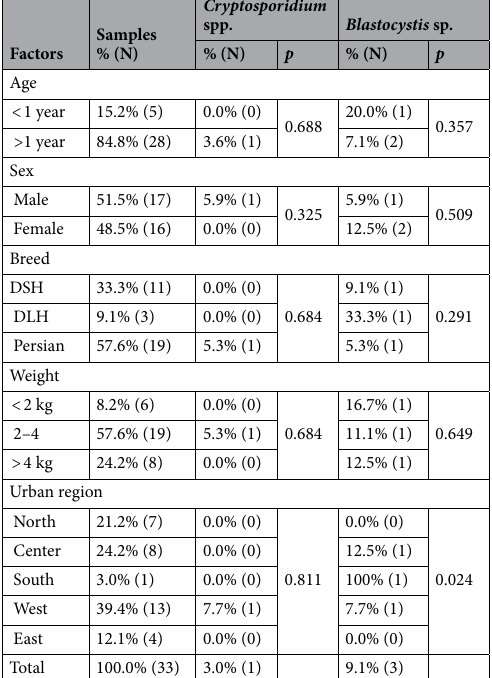
Table 3. The demographics and the prevalence of Cryptosporidium spp. and Blastocystis sp. in the household cats of Tehran, Iran.